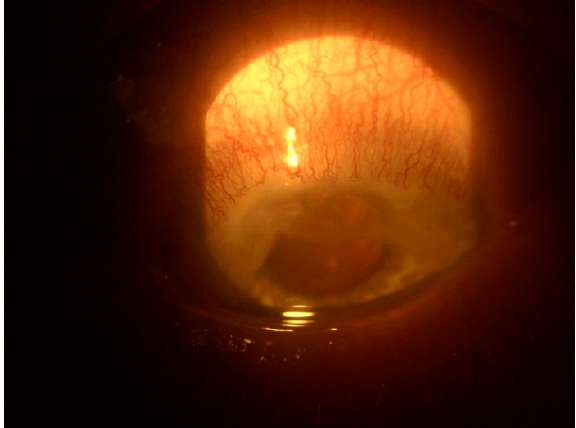
Figure 4. Peripheral ulcerative